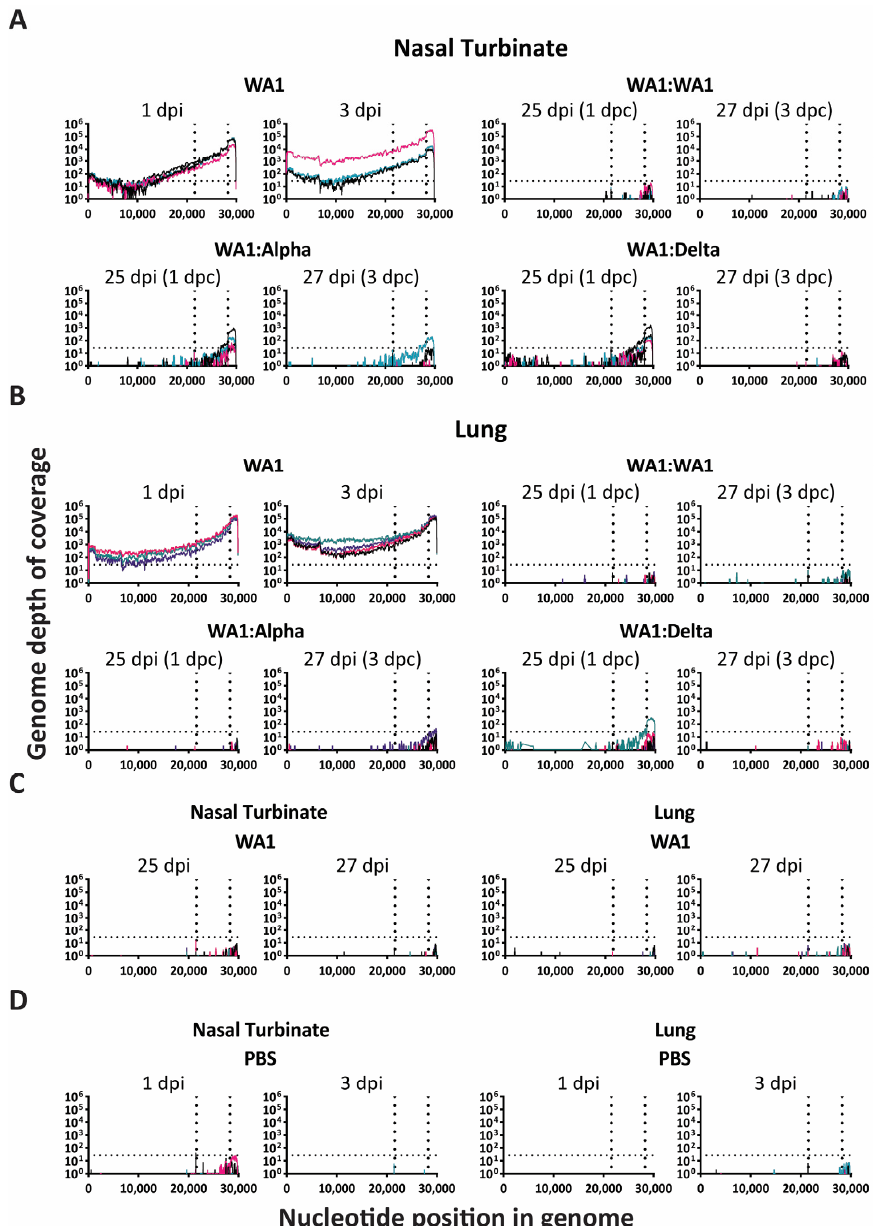
Figure 3. Viral RNA in lungs and nasal turbinates of challenged mice is limited to subgenomic transcripts. RNA-seq data of the viral genome were graphed to show depth of coverage (Y-axis) by nucleotide position (X-axis) on the SARS-CoV-2 genome for nasal turbinate ( A , C , D ) and lung ( B – D ) samples. The first vertical dotted line marks the beginning of the subgenomic region (the start of the spike) and the second vertical dotted line marks the beginning of the nucleocapsid encoding region. The horizontal dotted line represents the limit of detection. Abbreviations: dpi—days post-infection; dpc—days postchallenge. Each colored line represents the results from one mouse.